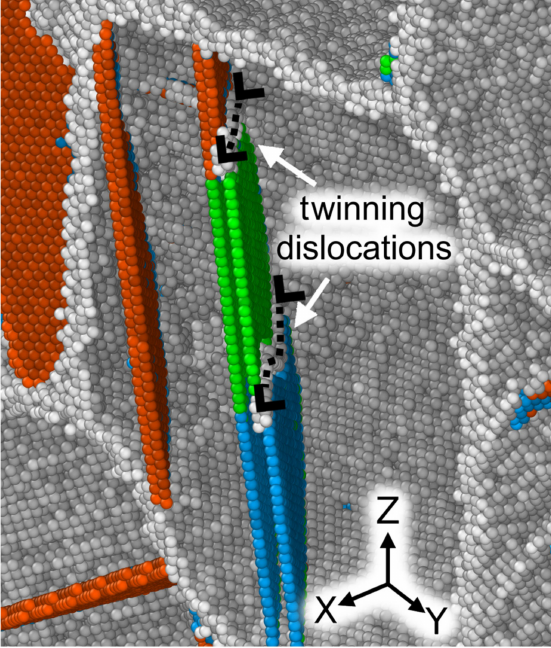
Figure 5. Transformation of ISF into a twin in a medium grain. ISFs are shown in red, boundaries of twin with one atomic plane thickness are green, boundaries of twin with more than one atomic plane thickness are blue, and atoms with uncertain nearest neighbor symmetry (GBs and dislocations) are gray. Atoms with fcc nearest neighbor symmetry are not